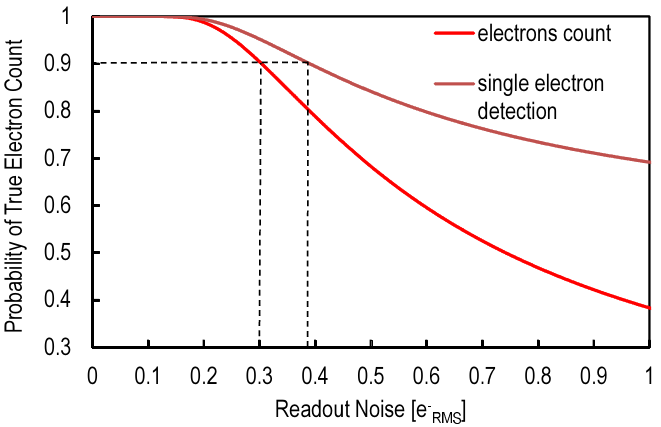
Figure 3. Probability of a true photo-electron count and single photo-electron detection as a function of the input-referred readout noise.